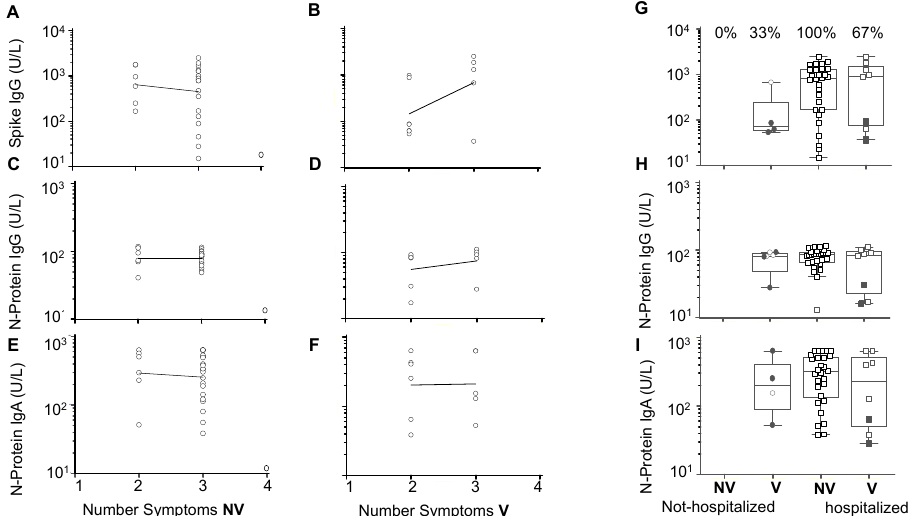
Figure 4. Antibody responses in SARS CoV-2 Delta variant infection and associations with COVID- 19 symptoms and hospitalization. Linear regression analysis of the anti-S protein IgG, the anti-N protein IgG, and the anti-N protein IgA levels versus the number of symptoms in non-vaccinated COVID-19 ( A , C , E ); coefficients of correlation r = − 0.04 (95% CI − 0.41–0.34), p = 0.884; r = − 0.06 (95% CI − 0.43–0.33), p = 0.78; r = − 0.095 (95% CI − 0.46–0.3), p = 0.6, respectively. Anti-S protein IgG, ( B ), anti-N protein IgG ( D ), and N-protein IgA ( F ) versus the number of symptoms in one or two dose vaccinated COVID-19; r = 0.5 (95% CI − 0.17–0.833), p = 0.1, r = 0.24 (95% CI − 0.416–0.74), p = 0.47 and r = 0.02 (95% CI − 0.58–0.6), p = 0.95, respectively. The distribution of anti-S protein IgG ( G ), anti-N protein IgG ( H ), and anti-N protein IgA ( I ) levels in non-hospitalized versus hospitalized COVID- 19. NV= not vaccinated, V = vaccinated. Filled symbols represent cases receiving two doses of vac- cine. The percentages (%) of V and NV are indicated.